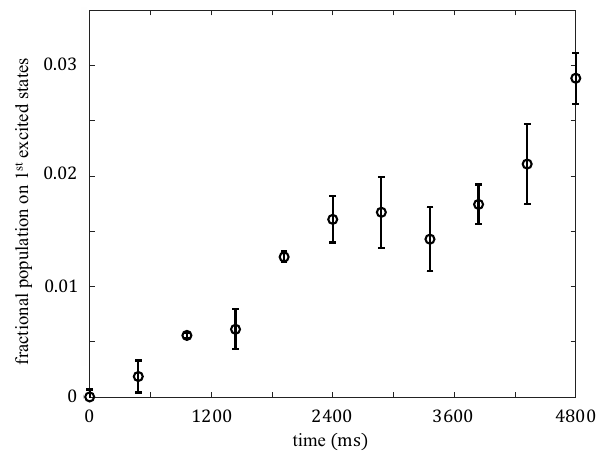
Figure 12: Time evolution of the fraction of the first transversely excited state for 1D gases held in lattice without Bragg pulses ( N = 130). The error bars denote the standard deviation of five measurements.